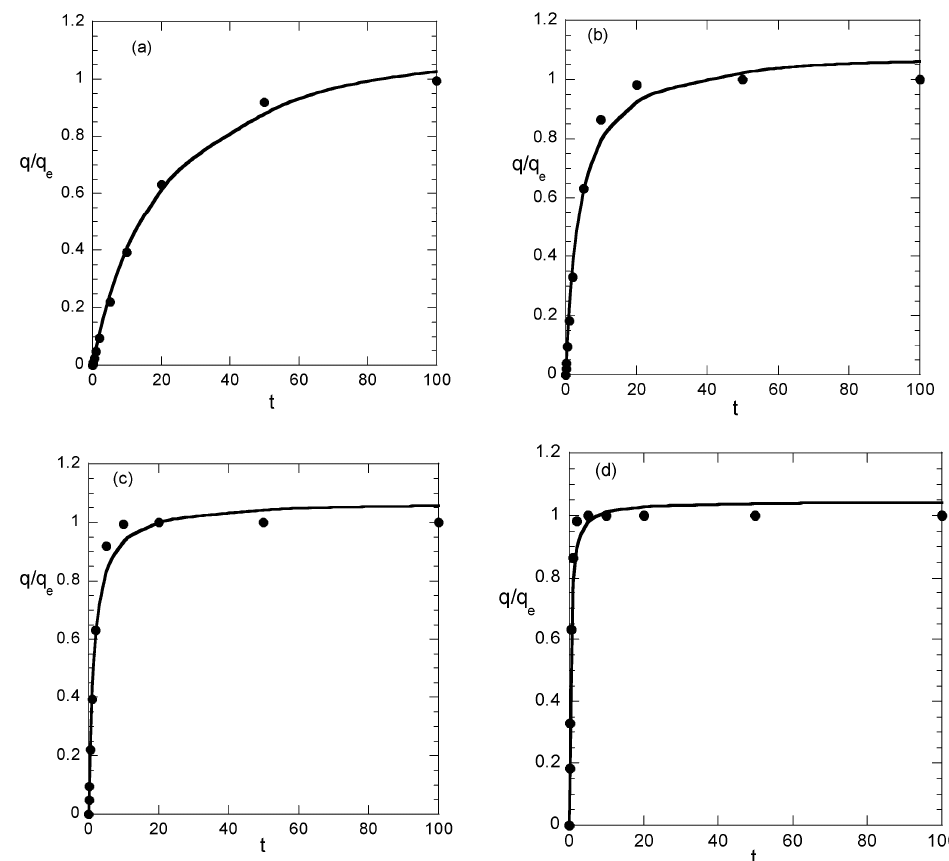
Figure 1. Example 1: Pseudo-second order nonlinear fits (continuous lines) to pseudo-first order data (symbols) for ( a ) α = 0.05, ( b ) α = 0.2, ( c ) α = 0.5, ( d ) α =